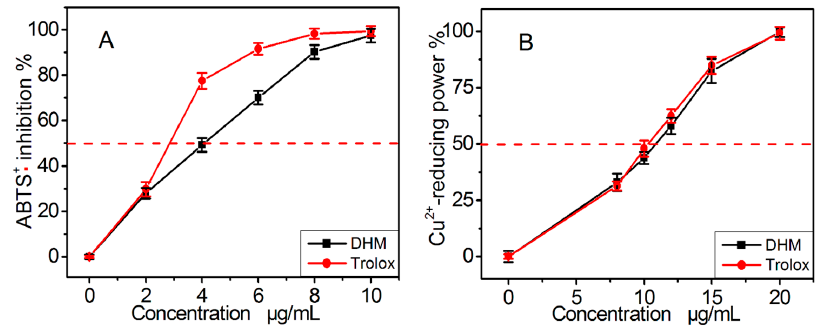
Figure 4. The dose response curves of dihydromyricetin (DHM) and positive control Trolox in the ABTS• + radical-scavenging assay ( A ) and Cu 2+ -reducing power assay ( B ). Each value is expressed as the mean ± SD ( n = 3). Trolox, [(±)-6-hydroxyl-2,5,7,8-tetramethlychroman-2-carboxylic acid].